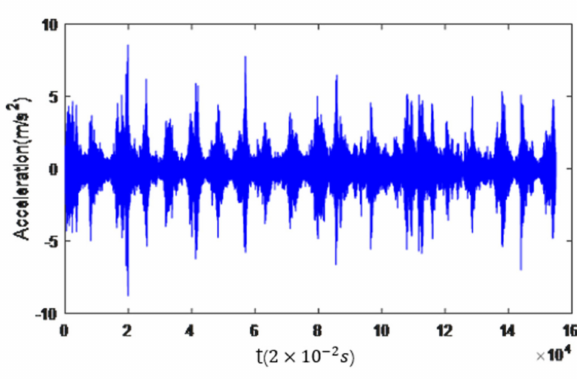
Figure 13. Mid − span acceleration data from 12:00 to